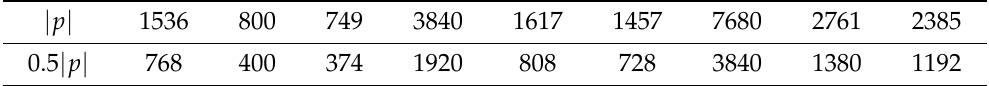
Table 4. Coppersmith’s upper